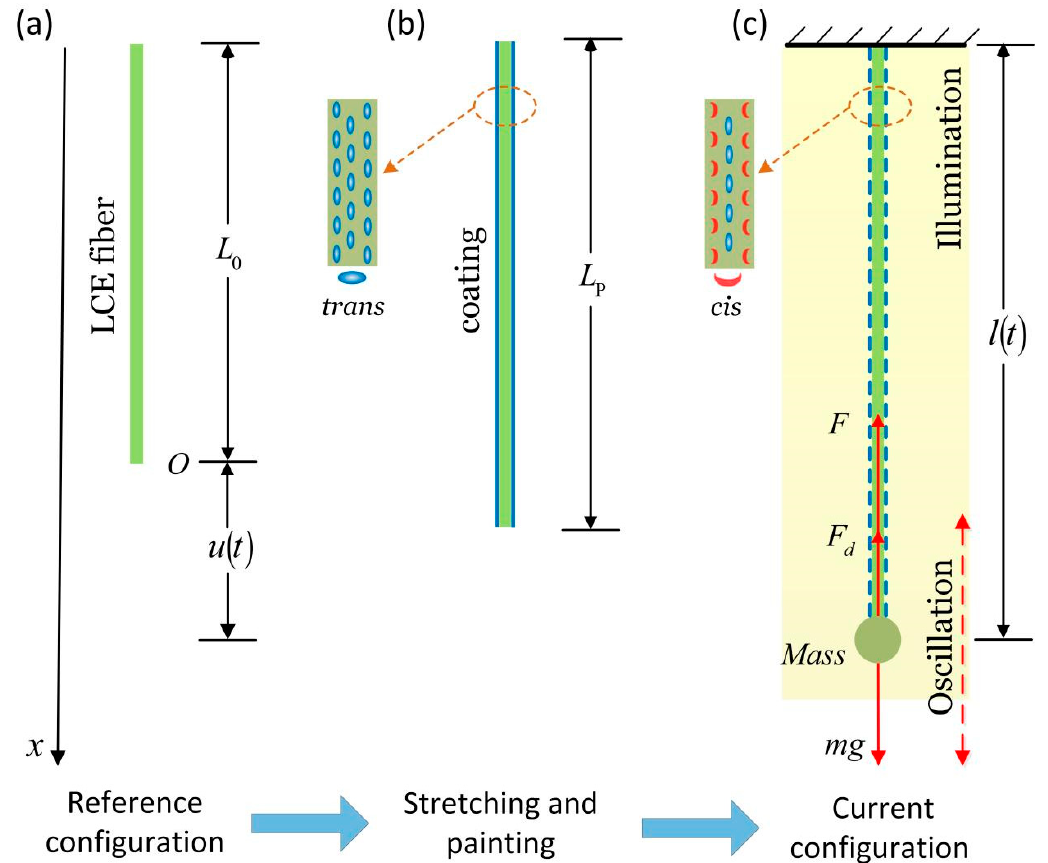
Figure 2. Schematic of an optically responsive LCE spring oscillator made of a mass block and an LCE fiber coated with an opaque powder coating under steady and homogeneous illumination. ( a ) Reference configuration of the LCE fiber; ( b ) the LCE fiber is pre-stretched to the length of p L (we